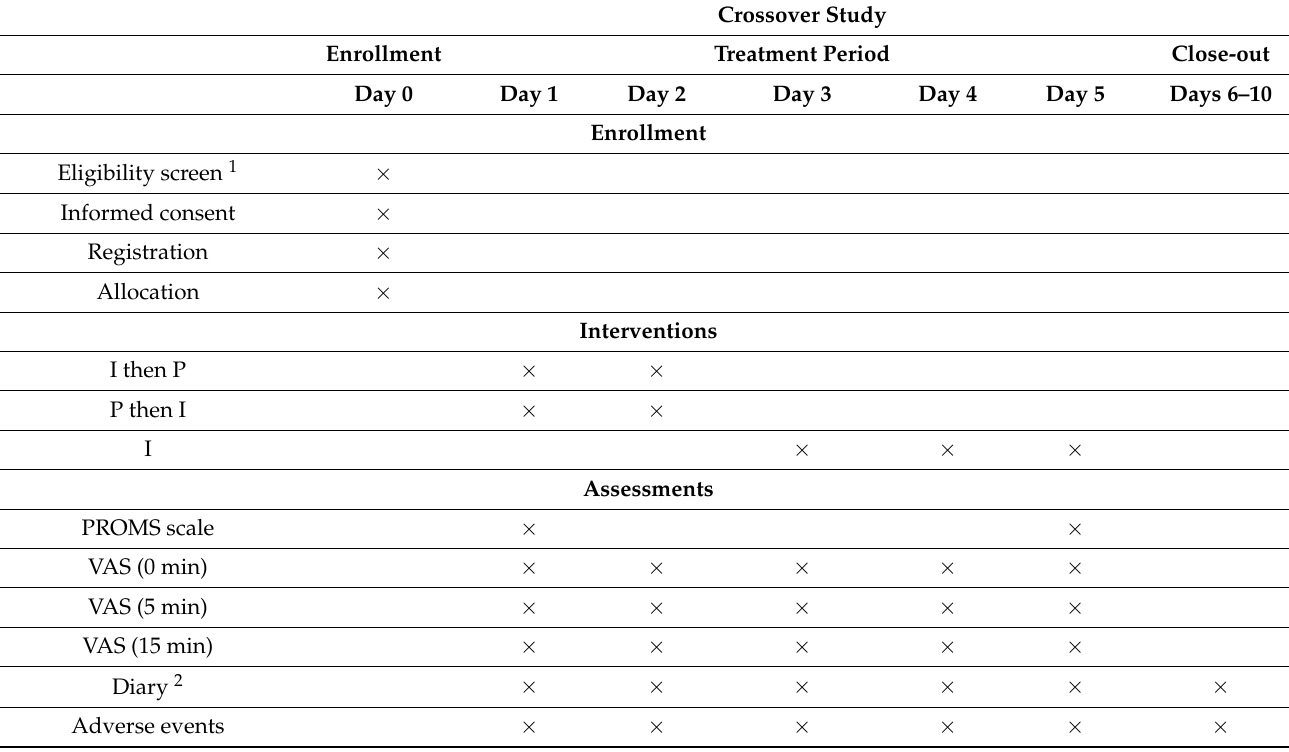
Table 4. Summary of the study assessments and procedures in the crossover study.